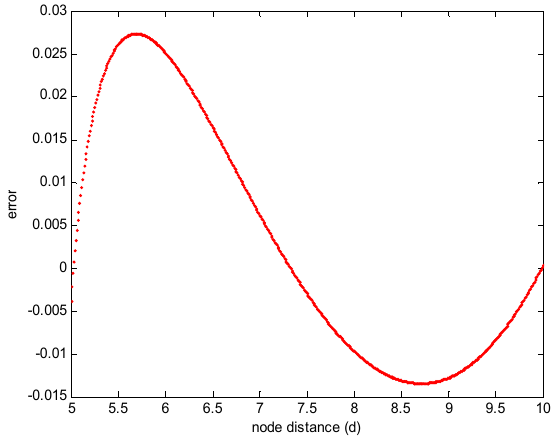
Figure 12. The evaluation error between s and f .